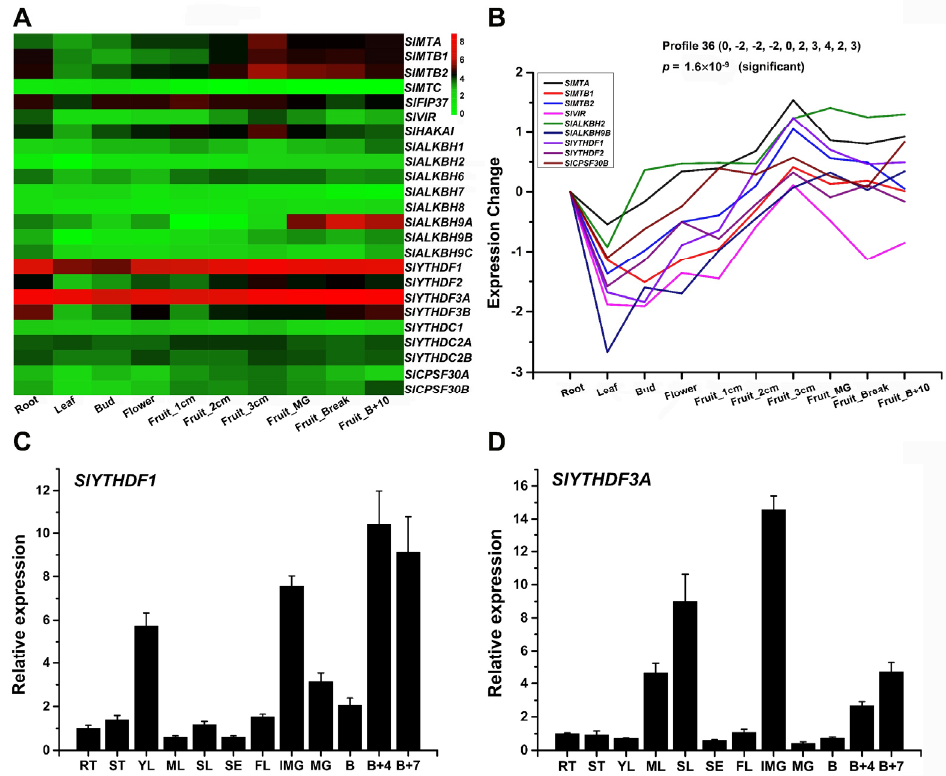
Figure 5. Heat map representation of the tomato m 6 A genes in various tissues. ( A ) Expression levels of tomato m 6 A genes in Heinz 1706 tomato based on transcriptome expression data. Each column represents a different tissue at different developmental stages of tomato. The bar on the right indicates normalized expression data from high to low (red to green). ( B ) STEM analysis. The expression data of each gene in root was normalized as 0. ( C , D ) Expression of SlYTHDF1 and SlYTHDF3A in different tissues of Ailsa Craig tomato. RT, root; ST, stem; YL, young leaf; ML, mature leaf; SL, senescent leaf; SE, sepal; FL, flower; IMG, immature green; MG, mature green; B, breaker stage; B+4, 4 days after breaker stage; B+7, 7 days after breaker stage. Data are the mean ± SE of three independent experiments.